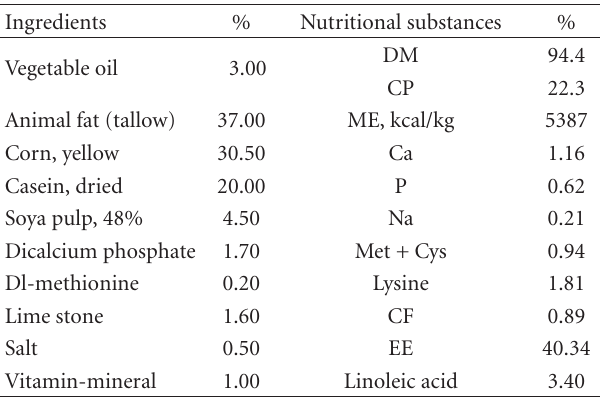
Table 1: High fat diet composition and nutritional